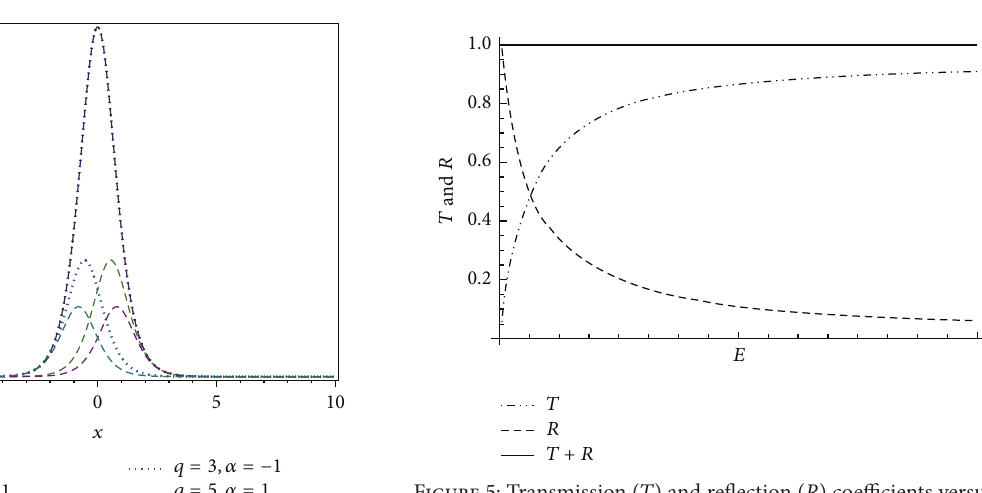
Figure 4: The plot of the qHPT potential as a function of position 𝑥 with 𝑞 = 1, 0 . 75, and 0 . 5 and 𝛼 = 0 . 05 for 𝑥 < 0 and 𝑥 > 0, respectively.